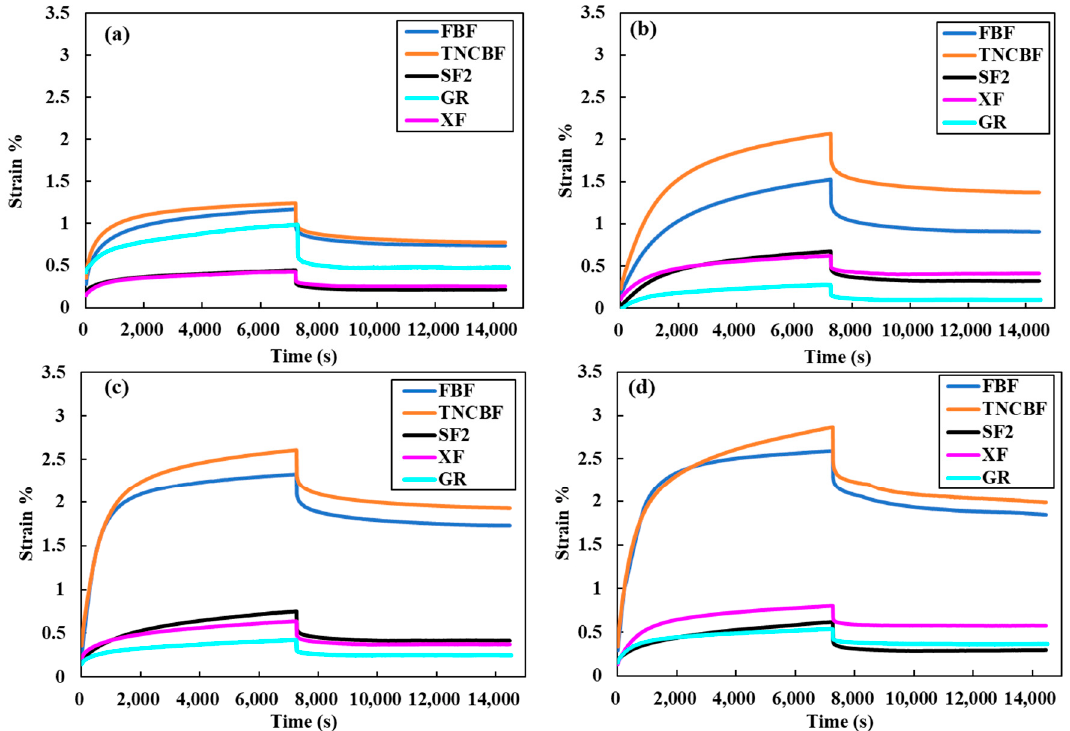
Figure 7. Creep deformation and recovery behavior of different Bulk fill composites in same solvent: ( a ) dry: control group; ( b ) distilled water; ( c ) artificial saliva; and, ( d ) absolute ethanol.